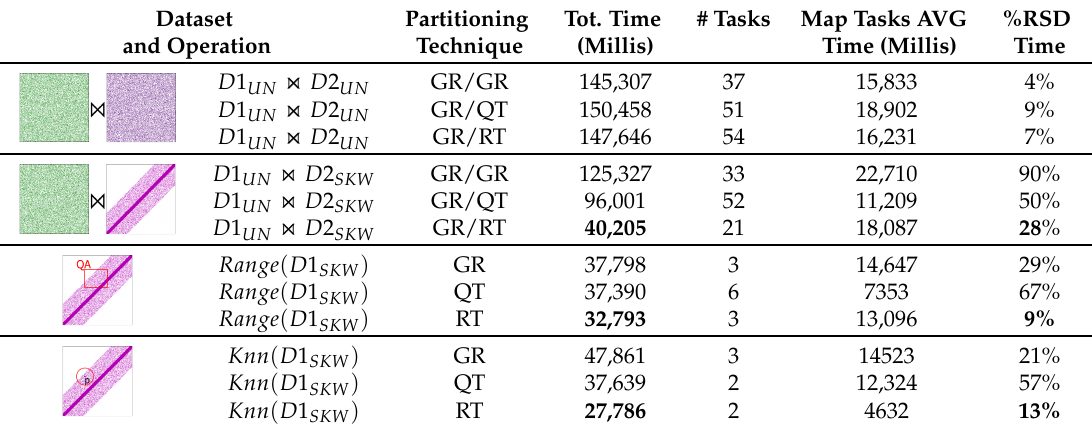
Table 1. Execution of the DJ, RQ and KNN operations in SpatialHadoop with datasets having different kind of partitioning (i.e., partitioning based on: GR = regular grid, QT = Quadtree or RT = R-tree) and having different distributions (i.e., UN = uniform distribution, SKW = skewed distribution). RSD is the standard deviation of running times between map tasks. Dataset Partitioning Tot. Time # Tasks Map Tasks AVG %RSD and Operation Technique (Millis) Time (Millis)